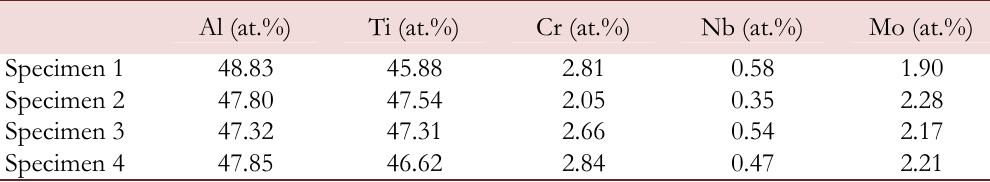
Table 1: Average composition of the CT specimens.